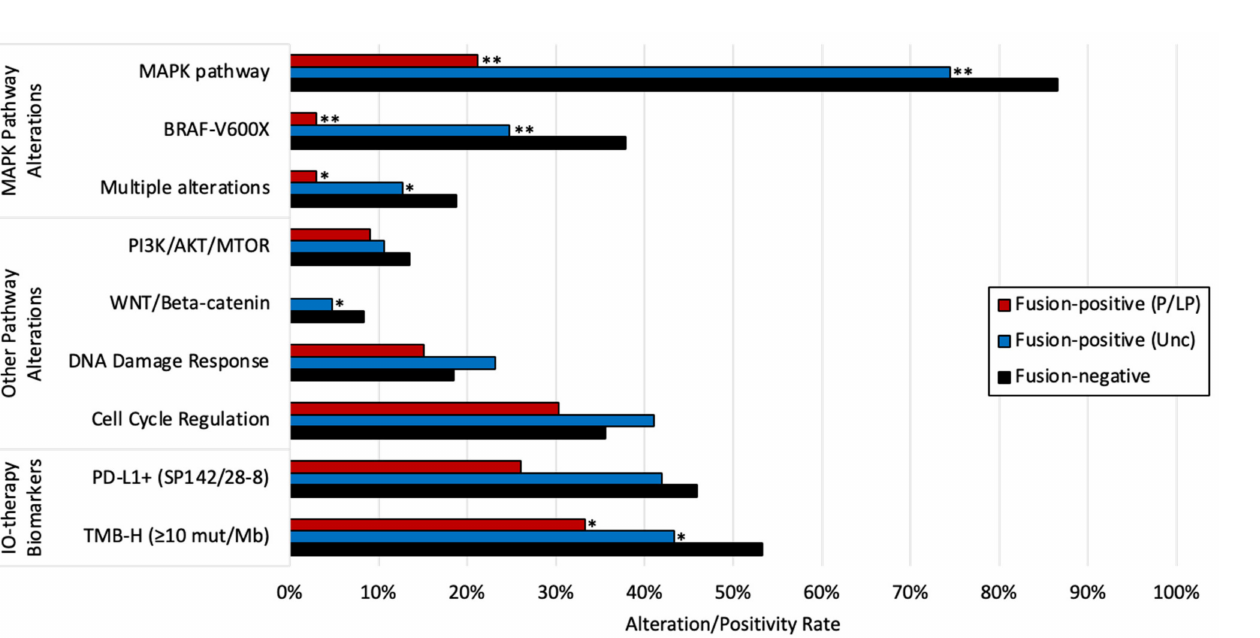
Figure 1. Prevalence of key pathway alterations and therapy-associated biomarkers in fusion-positive and fusion-negative tumors. * p < 0.05, ** Q < 0.05 (Benjamini–Hochberg). p -values reflect the comparison with the fusion-negative